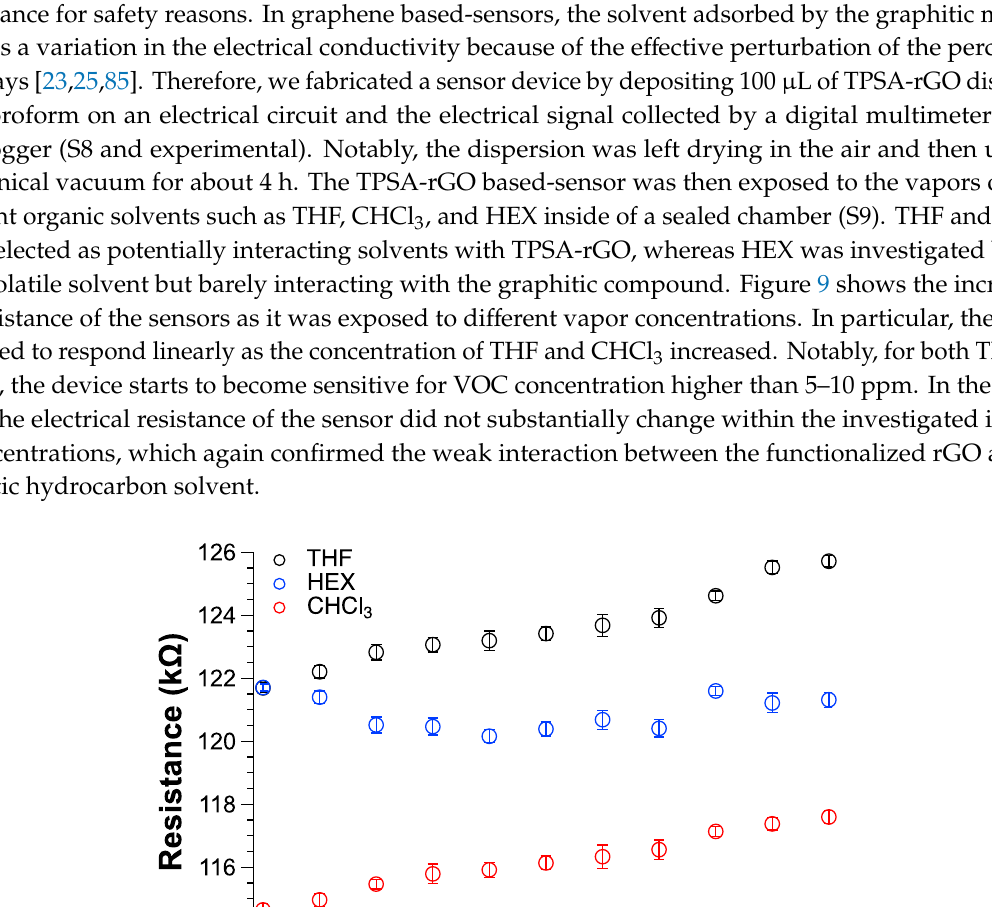
Table 4. Pearson correlation coefficient of the resistance variation in function of the solvent. Solvent Pearson Correlation Coefficient THF 0.90 HEX 0.05 CHCl 3